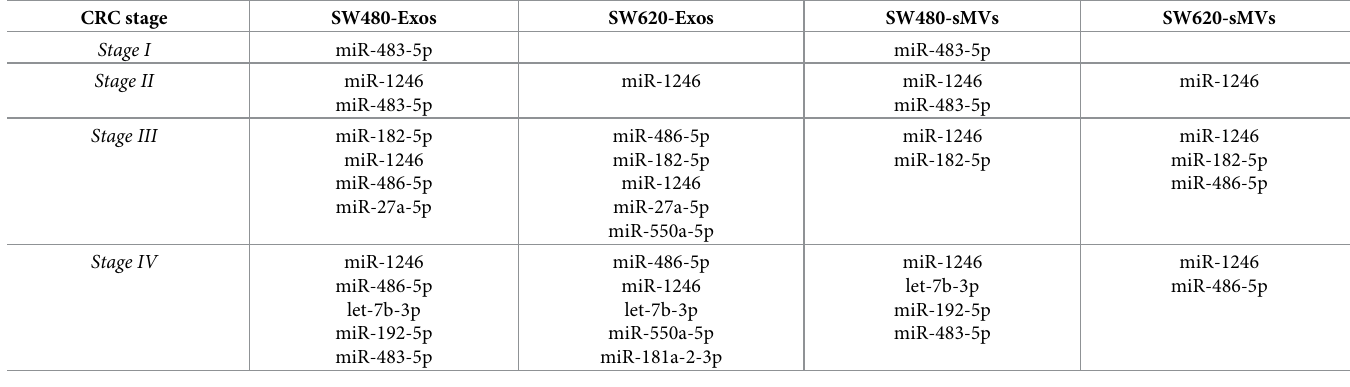
Table 3. Number of EV-enriched miRNAs up-regulated in exosomes isolated from CRC-patient plasma compared to exosomes from healthy individuals � . CRC stage